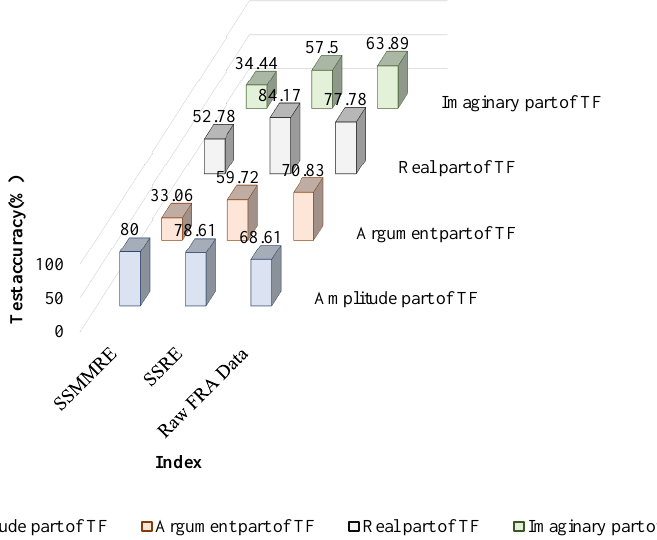
Figure 10. Evaluating the performance of the GMDH model in the determination of the DSV fault severity using direct data of FRA and the extracted features by statistical indices.